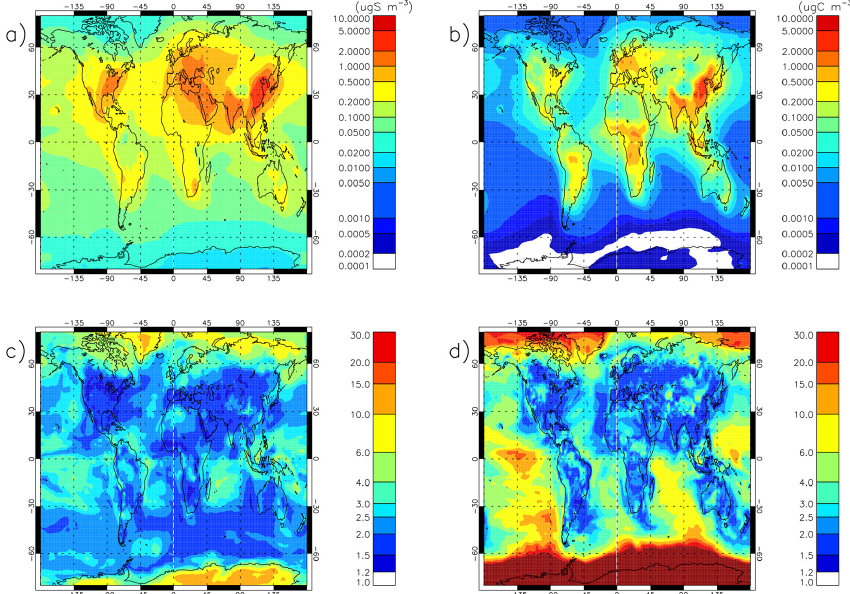
Figure 1. Global maps of central-8 model mean (panels a and b ) and diversity (panels c and d ) for simulated annual mean surface mass concentrations of sulfate (a, c) and black carbon (b, d) . Diversity here is the ratio of the maximum and minimum values over the central 8 of the 12 models (defined locally, as described in Sect. 2.4). Note that the geometric mean is used when averaging over the central-8